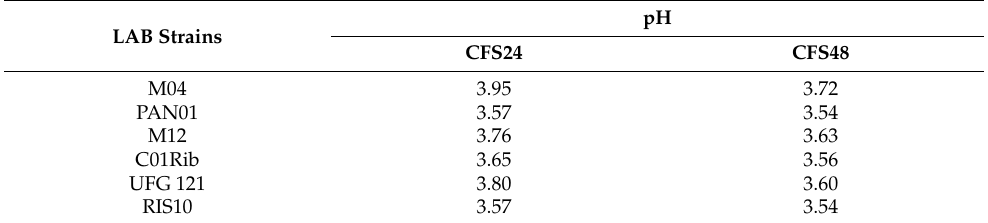
Table 2. pH of the CFSs obtained after 24 (CFS24) and 48 (CFS48) h of growth in MRS at 37 ◦ C.